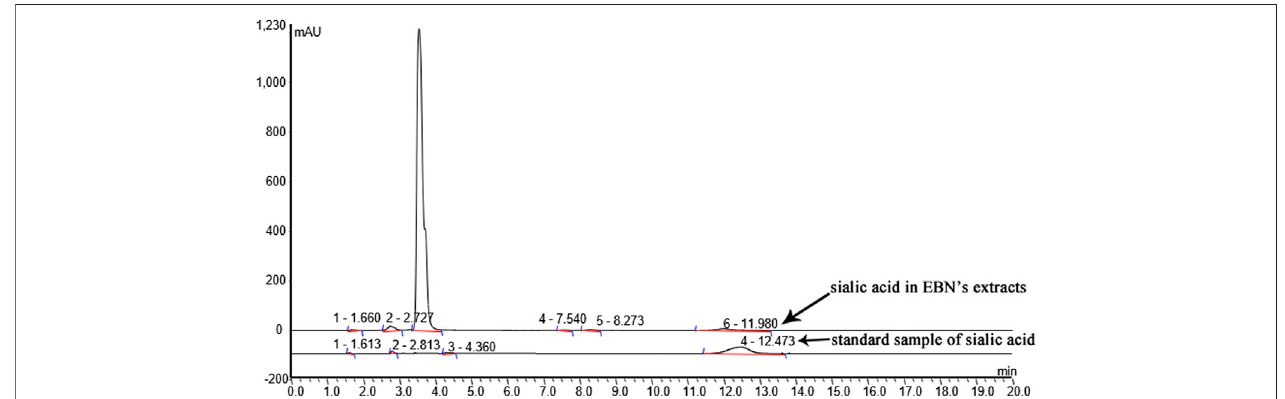
FIGURE 2 | Characterization of EBN